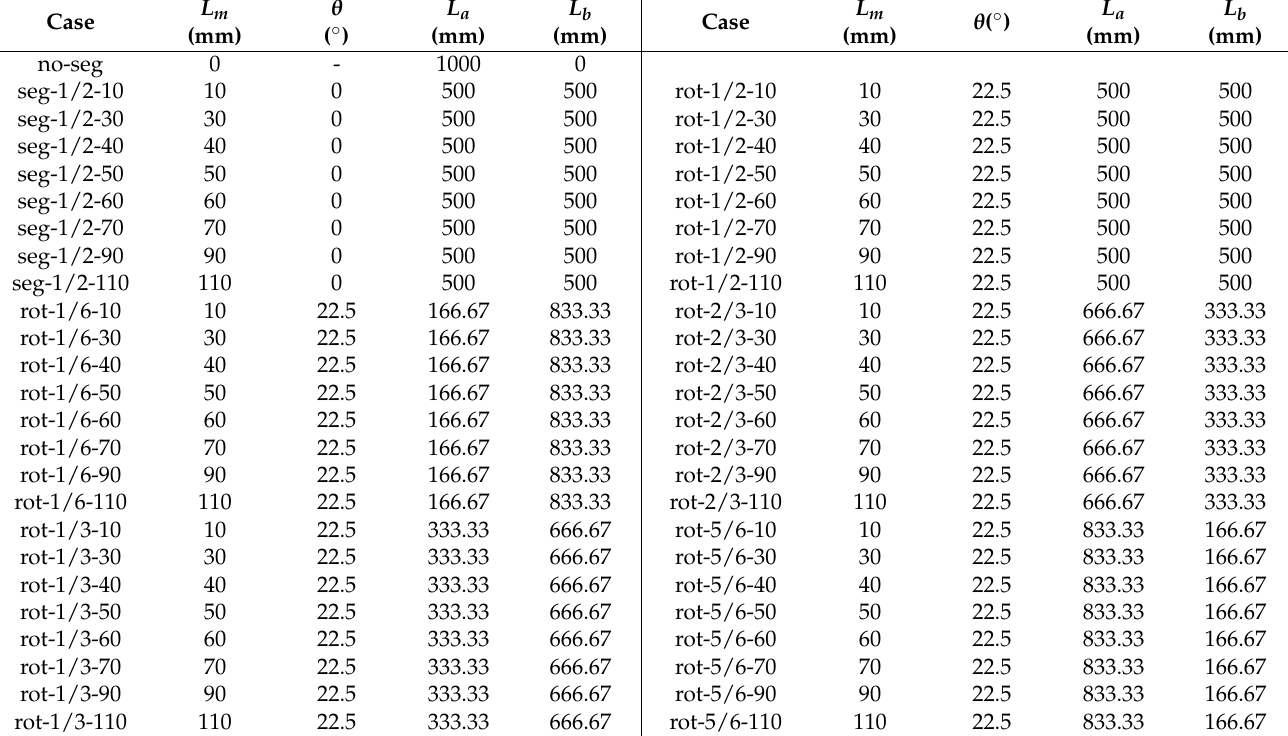
Table 2. The schemes of the simulation cases.